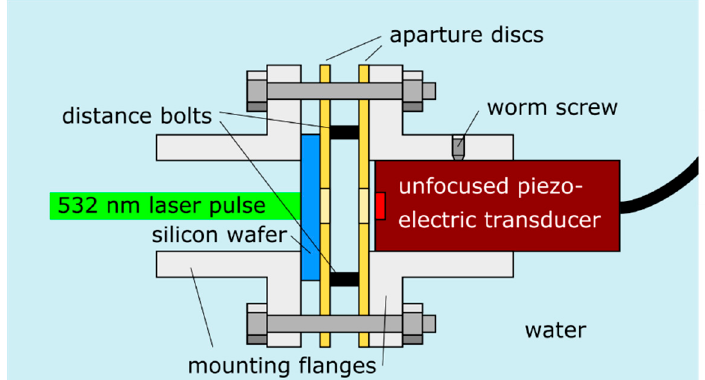
Figure 1. Experimental set-up for the generation and measuring of acoustic plane waves in water. Short laser pulses are directed on a silicon wafer. Fast local heating due to optical absorption leads to the emission of ultrasonic waves. The ultrasound detector is held by a mounting flange, and is axially fixated with a worm screw. The length of the water path between the silicon wafer (i.e., the ultrasound emitter) and the detector can be adjusted with distance bolts between two aperture discs. The silicon wafer is pressed onto one aperture disc by another mounting flange, which is bolted to the opposite flange.